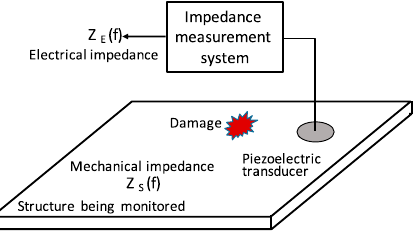
Figure 8. Principle of the EMI method.